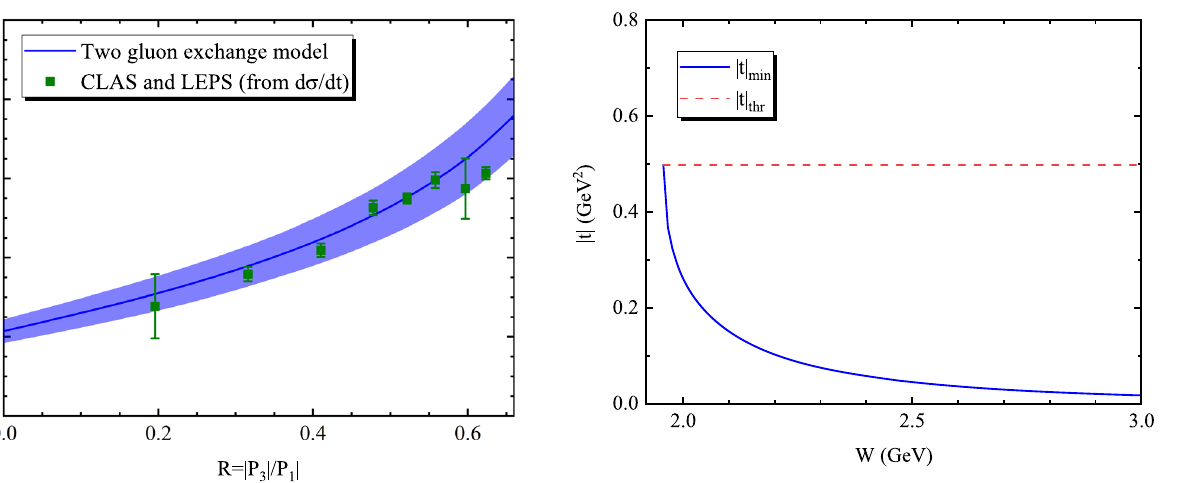
is (2 . 17 ± 0 . 30)%). This indicates that the trace anomaly